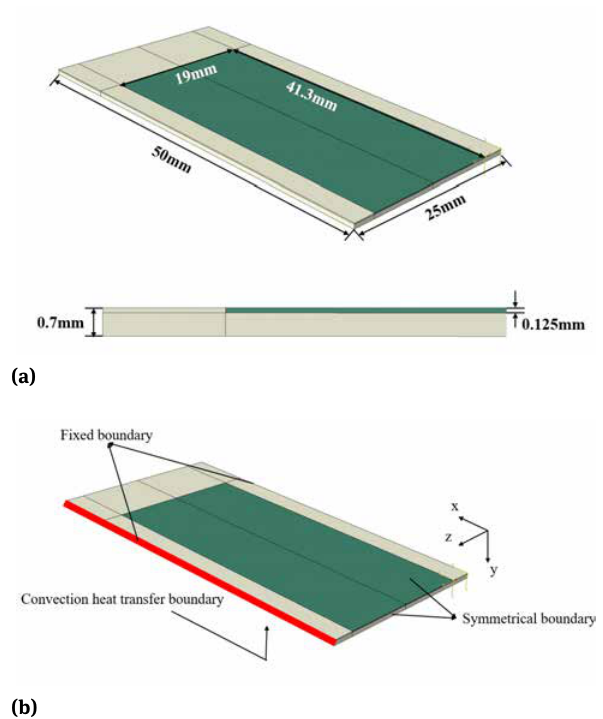
Figure 2: a) Finite element model and b) boundary